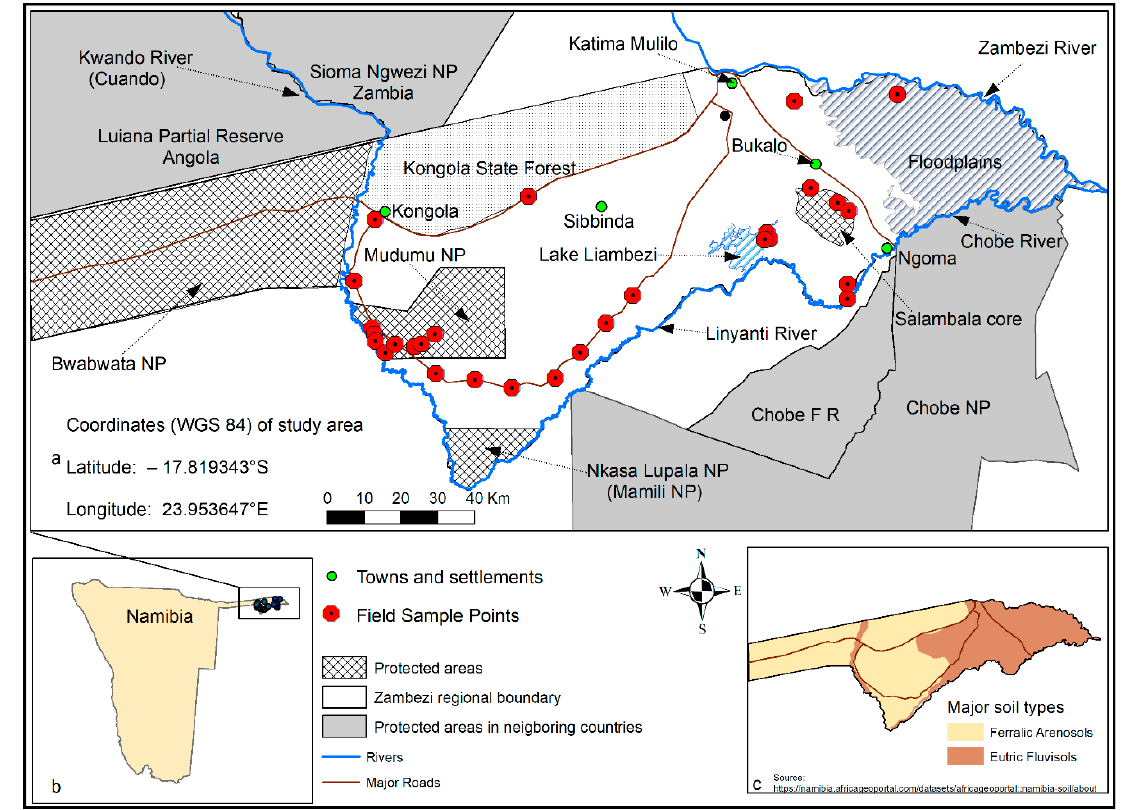
Figure 1. Study area, main roads, rivers, conservation areas, and field work way points for high resolution (2 cm) UAV data in ( a ). In ( b ), the map of Namibia, and ( c ) map of major soil types.